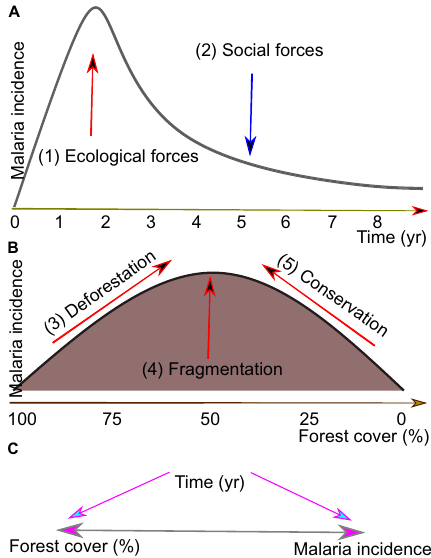
Figure 1. Theoretical background. ( A ) Malaria incidence increases in the early years of a human settlement in the Amazon, reaches a peak and then declines. This pattern is referred to as the FMH. A generalization of this pattern reveals that the most common curve of the malaria incidence distribution over time in a landscape impacted by changes in land use is convex. (1) Ecological forces: environmental driving forces in the high- risk scenario of malaria transmission at the beginning of colonization. (2) Social forces: a counterbalancing effect due to malaria commodities and life improvements that decrease malaria incidence over the long term. ( B ) malaria incidence increases with (3) deforestation: loss of forest cover from 100 to 50%. The underlying landscape mechanism linked to the DMH is (4) fragmentation: an increase in the frequency of forest fringe in the landscape that is the preferred habitat of Ny . darlingi . (5) Forest conservation in protected areas can result in a high frequency of humans at the forest fringe, increasing contact with Ny . darlingi . ( C ) the association between forest cover (or accumulated deforestation) and malaria incidence is affected by time, which is a factor that can modulate both variables in different ways. The forest cover-malaria incidence relationship can be bidirectional 5,8,16,17